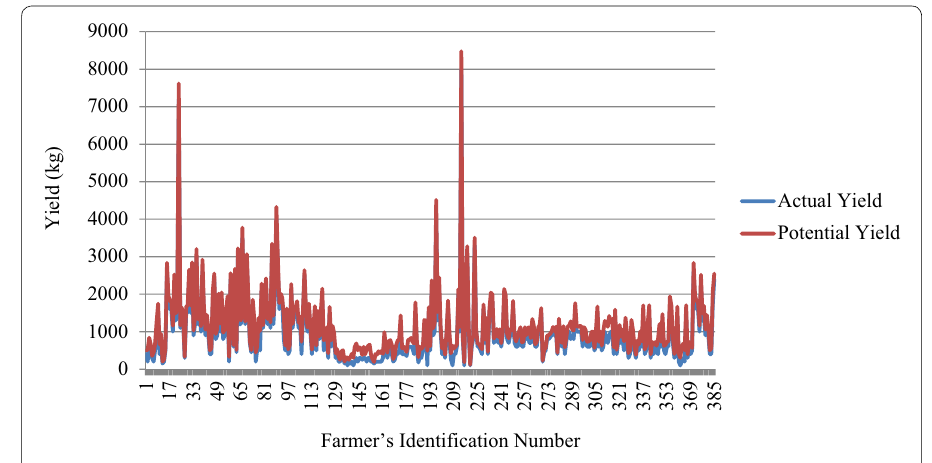
Fig. 4 Comparison of the actual and the potential level of yield Source : Own survey result (2018)